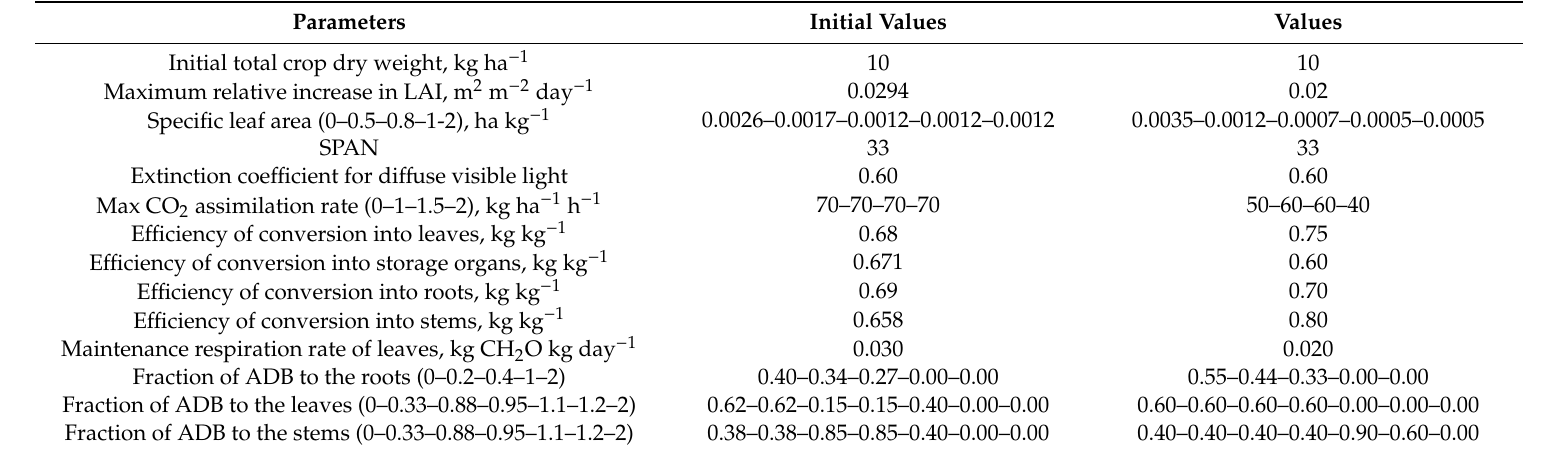
Table 6. Main crop parameters used in